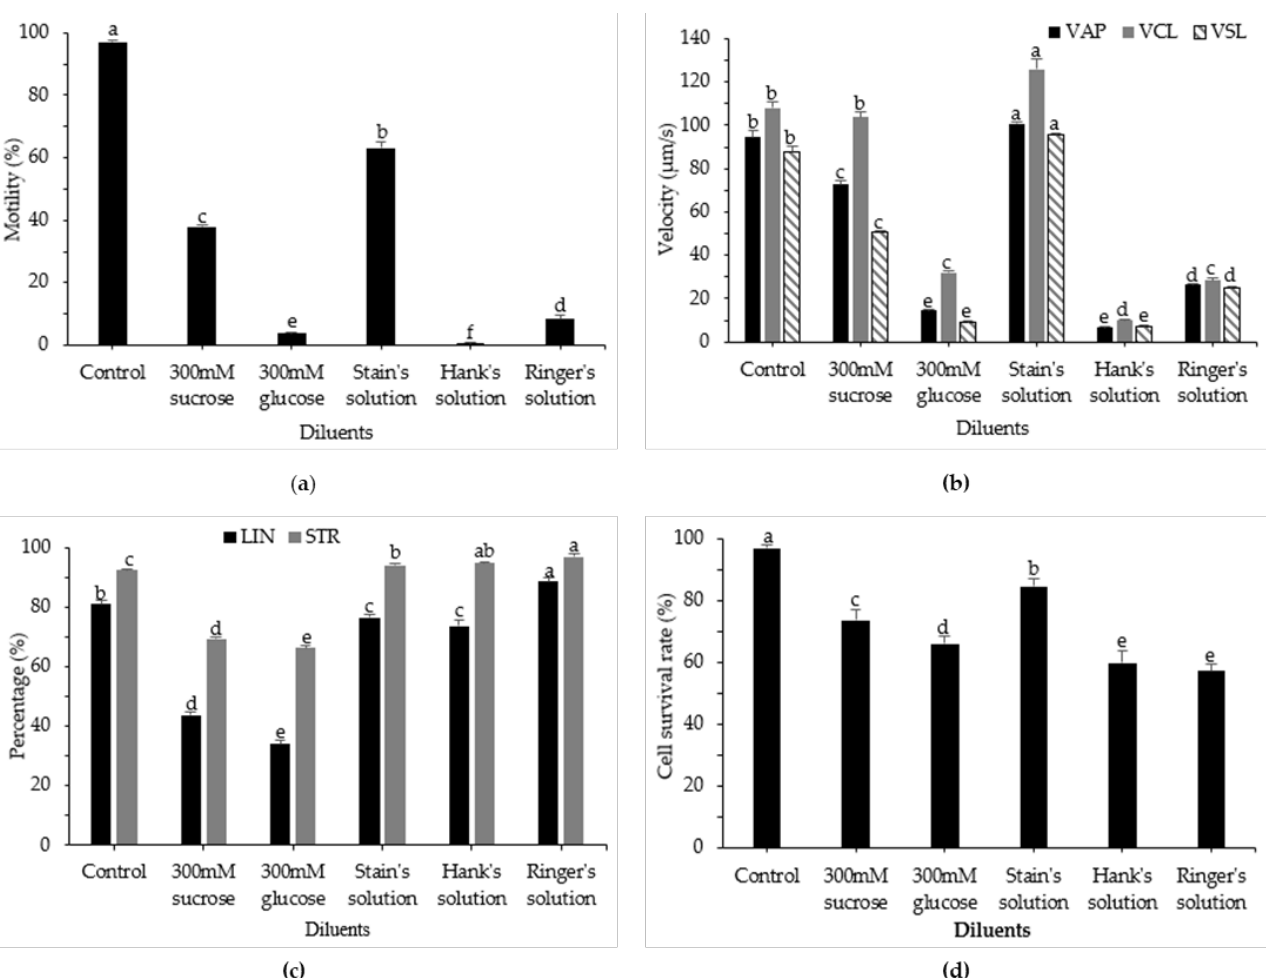
Figure 2. Computer-assisted sperm analysis of frozen and fresh sperm from roughscale sole, Clidoderma asperrimum , using various diluents with 10% DMSO as the cryoprotectant. ( a ) Motility (%), ( b ) average path velocity (VAP; µ m s − 1 ), curvilinear velocity (VCL; µ m s − 1 ), straight-line velocity (VSL; µ m s − 1 ), ( c ) linearity (LIN; %), straightness (STR; %), and ( d ) cell survival rate (%). Different lowercase letters indicate significant differences among diluents ( p < 0.05). Control, fresh